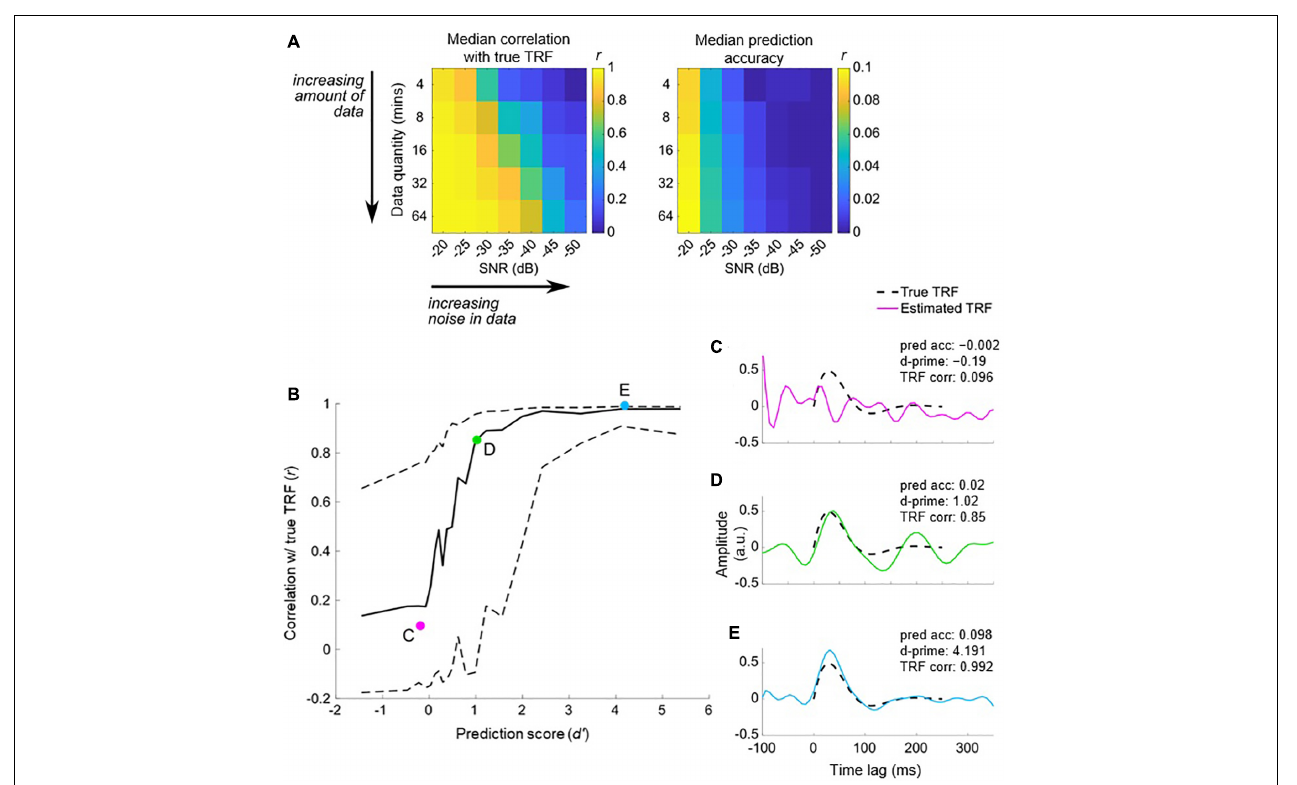
FIGURE 4 | Simulation of model performance as a function of data quality and quantity. Neural data were simulated using a TRF-like response with EEG-shaped noise (both filtered between 2–15 Hz) and randomly generated stimuli at different SNRs in the range [ − 20, − 50] dB and different numbers of trials (each trial is 1 min long). Each pairing of SNR and amount of data was simulated 100 times. (A) Median correlation coefficient between the true and modeled TRF (left) and median prediction accuracy (right) as a function of data quantity and SNR. Leave-one-trial-out procedure was used to quantify prediction accuracy of the trials, and for each simulation we averaged prediction accuracies across trials. Both prediction accuracy and the model estimate of the true TRF decrease with increasing amount of noise and decreasing number of trials. In light of this, we collapsed the data across conditions and plotted the relationship between prediction accuracy and model TRF to true TRF correlation across simulations (B) . d-prime prediction accuracy was used to normalize for differences in the null distribution, which can vary with the frequency range of the data. Shown for each condition are the median (solid line) and the 10–90% quantiles (dashed lines). As prediction accuracy decreases, the model estimate of the true TRF gets less reliable. (C–E) Shown are example stimulations with poor, moderate, and good estimates of the TRF, respectively ( C: − 45 dB SNR, 64 min; D: − 25 dB SNR, 4 min; E: − 20 dB SNR, 64 min). The root-mean-square of the estimated TRFs were normalized in this plot to match the true TRF. The d-primes and correlations between the true and predicted model for each simulation have also been labeled in (B) using the same colors of the traces in (C–E)